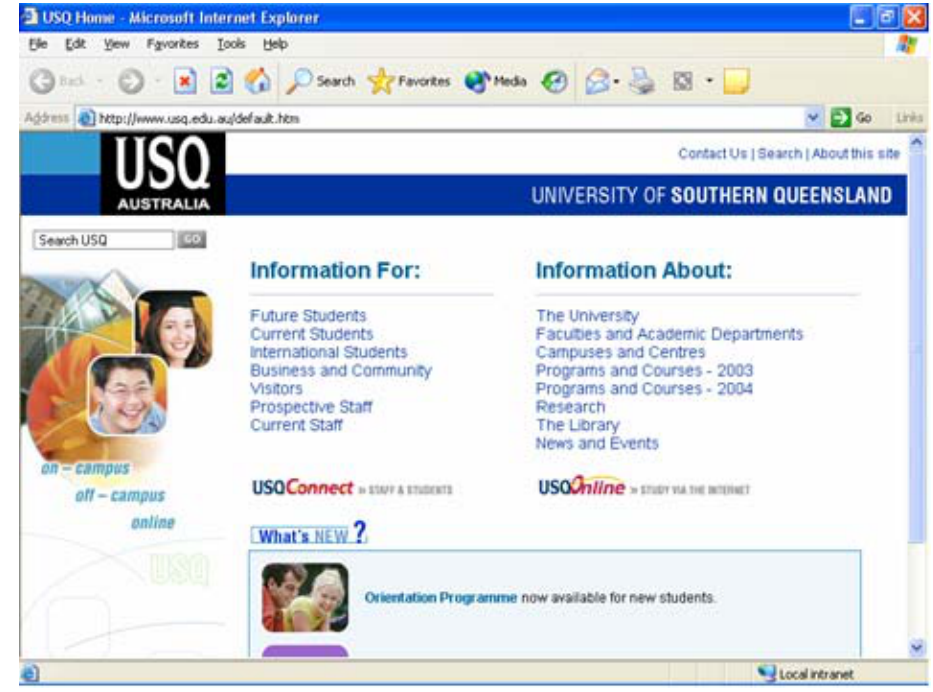
Figure 5. USQ Website